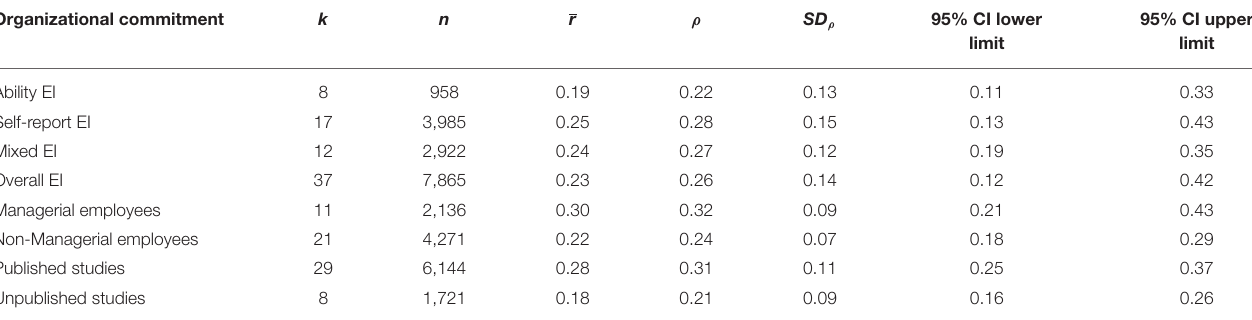
TABLE 3 | Meta-analytic results of the relationship between EI and organizational commitment.